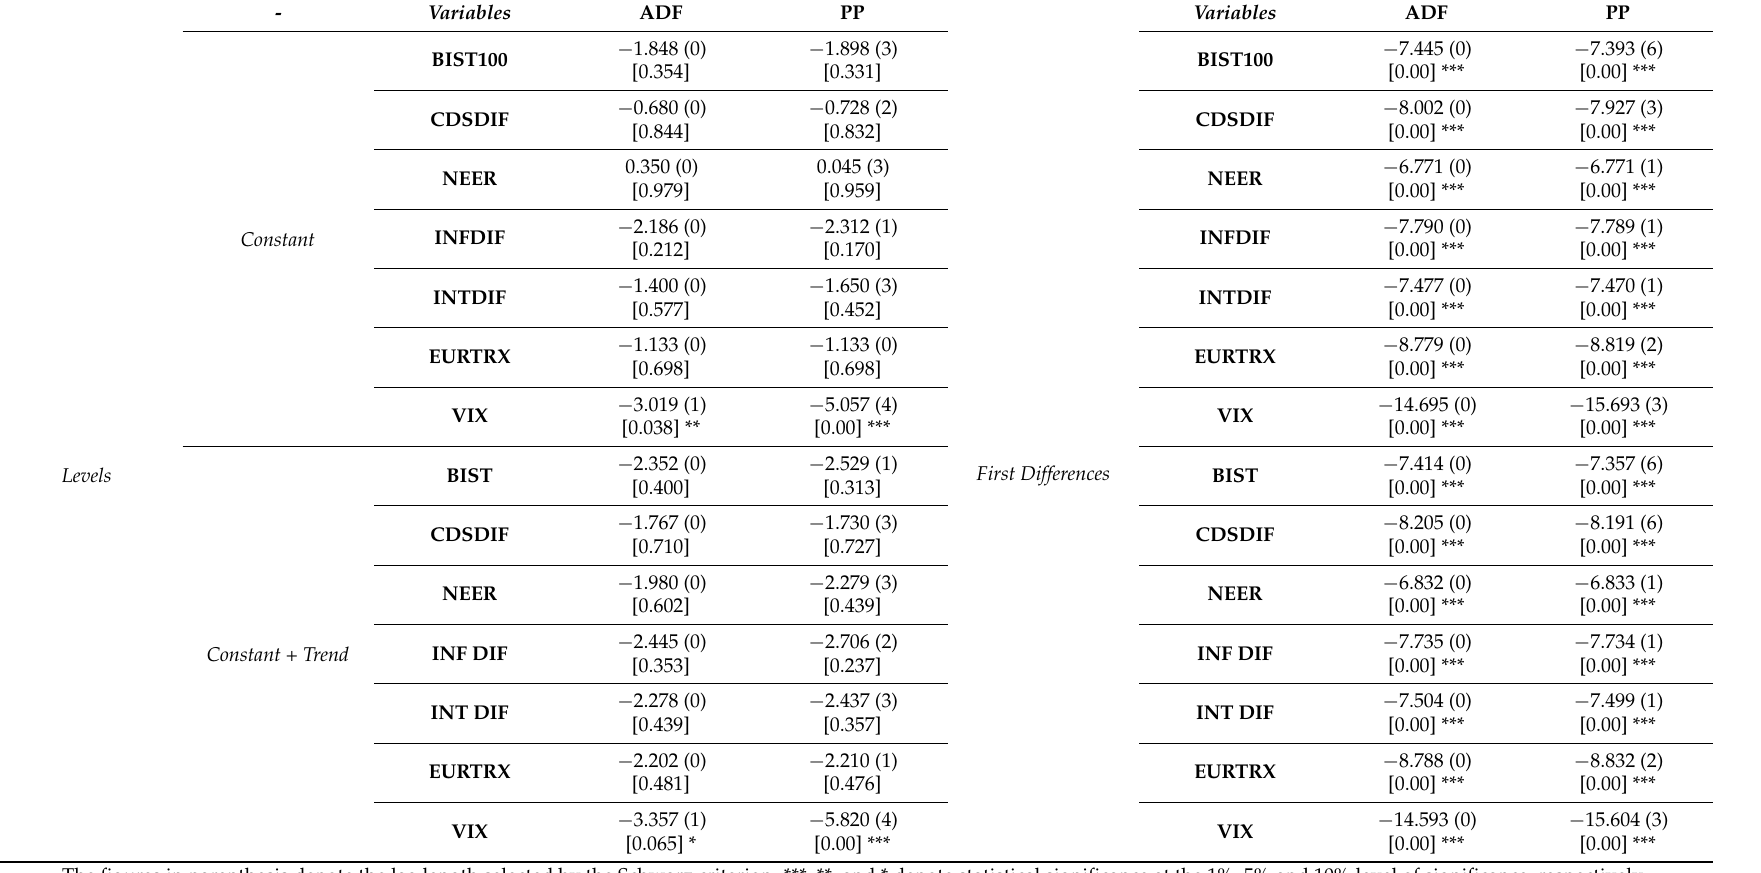
Table 2. ADF and PP unit root test